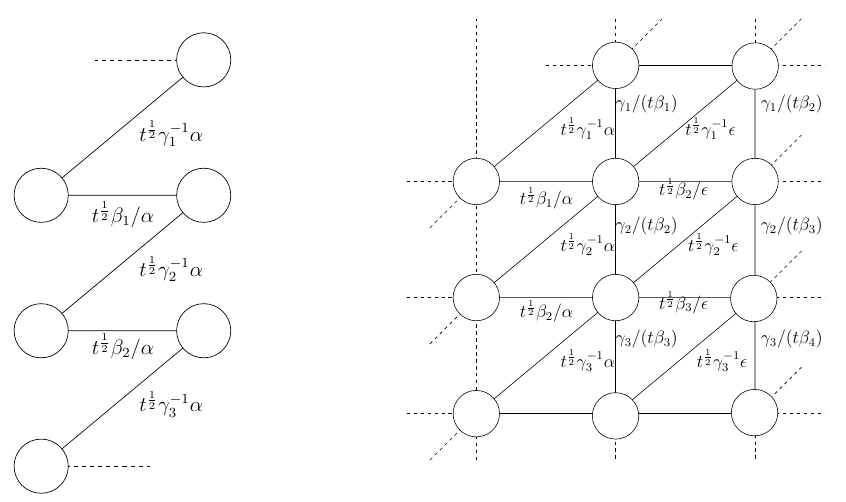
Figure 1 . On the left we have the free trinion. This is a collection of N 2 (2 k ) free (cid:12)elds. We organize these as bifundamentals of two copies of su ( N ) k . In the picture the circles are su ( N ) groups and one has k groups winding around a cylinder. The trinion is associated to a compacti(cid:12)cation on a sphere with two maximal punctures (of di(cid:11)erent color) and a minimal puncture. On the right we glue trinions together to triangulate a torus. We have lk trinions combined with every (cid:8) gluing introducing bi-fundamental (cid:12)elds which appear as vertical lines in the